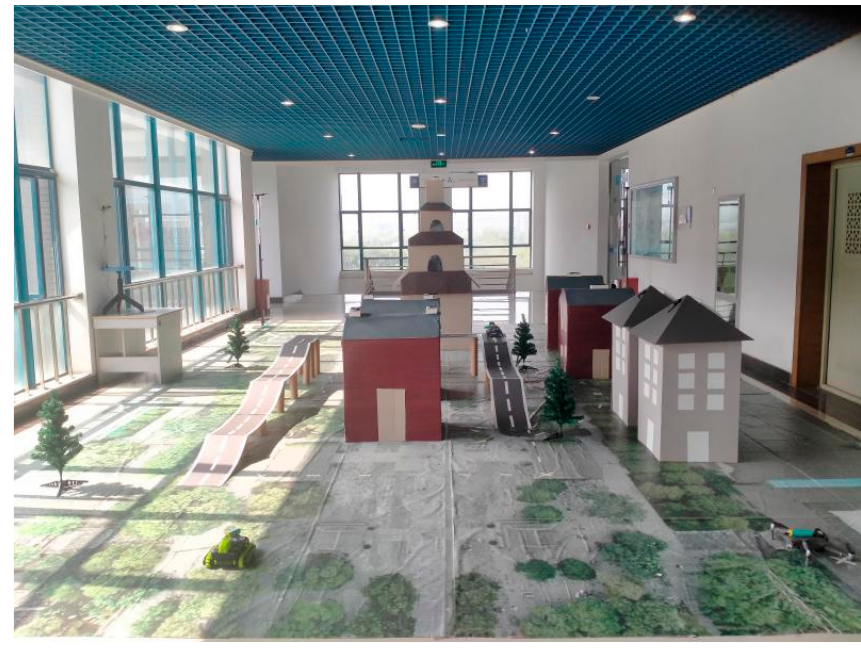
Figure 9. The verification platform.